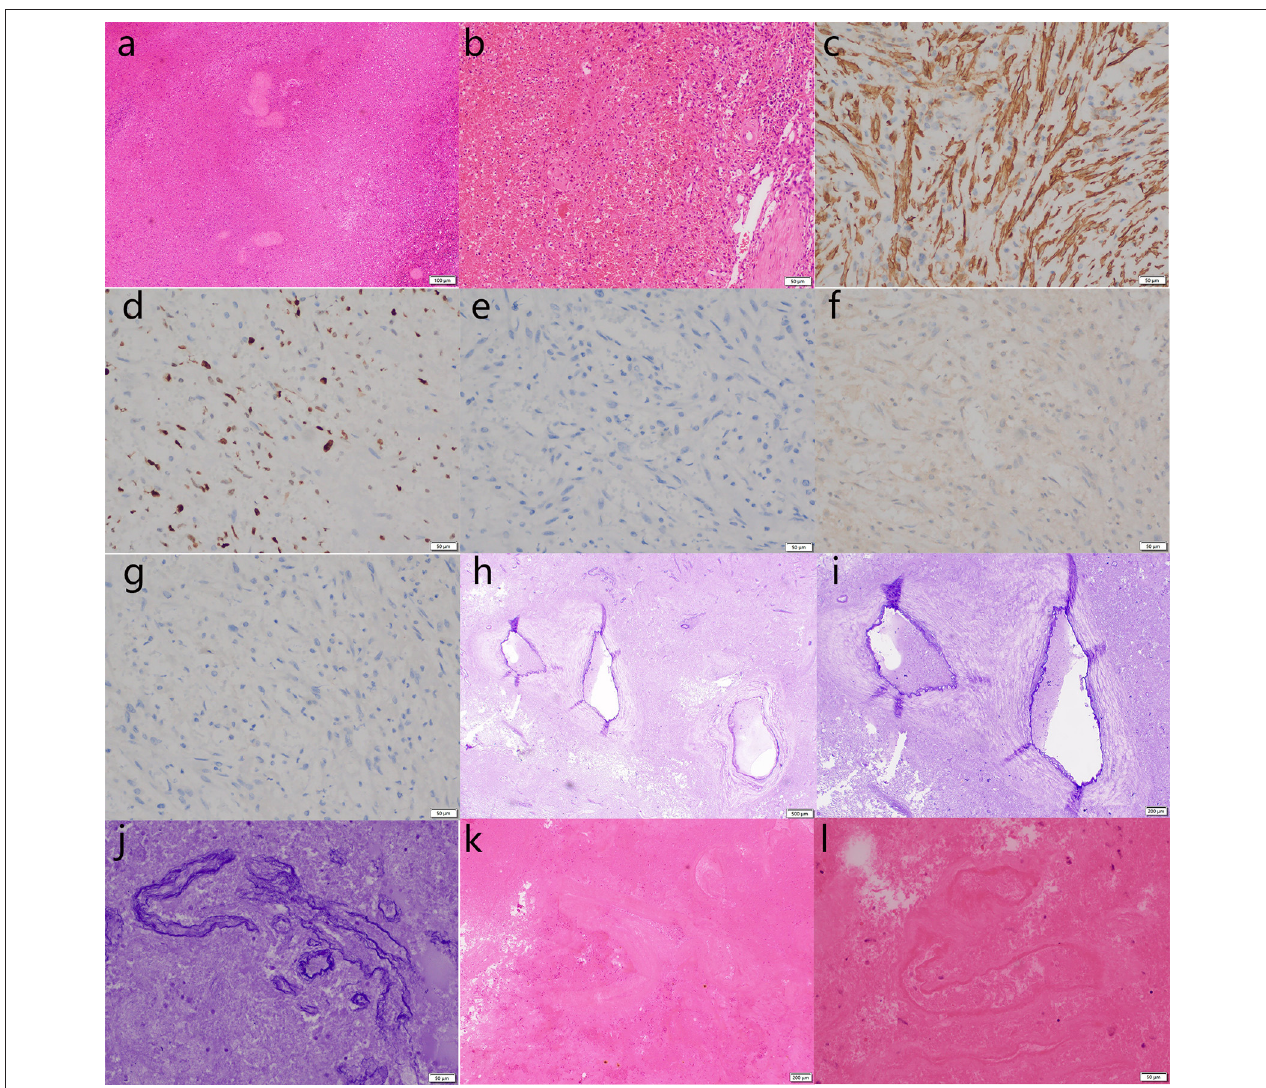
FIGURE 3 | Pathological biopsy of the splenectomy specimen shows large hemorrhage and necrosis under microscope, and abnormally proliferated vascular tissue around the hemorrhage area [hematoxylin & eosin staining; (a) × 100; (b) , × 200; (k) , × 40; (l) , × 200]. Vascular tissue (elastic fiber staining + ), blood vessel wall tissue (elastic fiber staining + ), and local hyperplasia of myofibroblastic cells are shown [ (h) , × 20; (i) , × 40; (j) × 200]. Immunohistochemistry showed actin [SM + , (c) × 200], Ki67 [10% + , (d) × 200), ALKp80 [–, (e) × 200], melanA [–, (f) × 200], HMB45 [–, (g) × 200]. The above findings are consistent with a splenic hemangioma with ruptured hemorrhage and